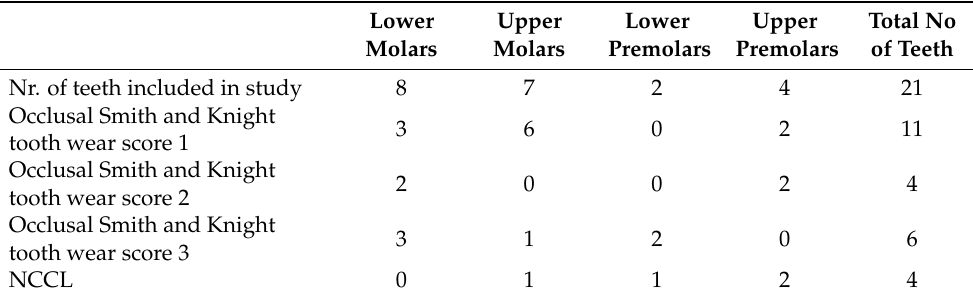
Lower Upper Lower Upper Total No Molars Molars Premolars Premolars of Teeth